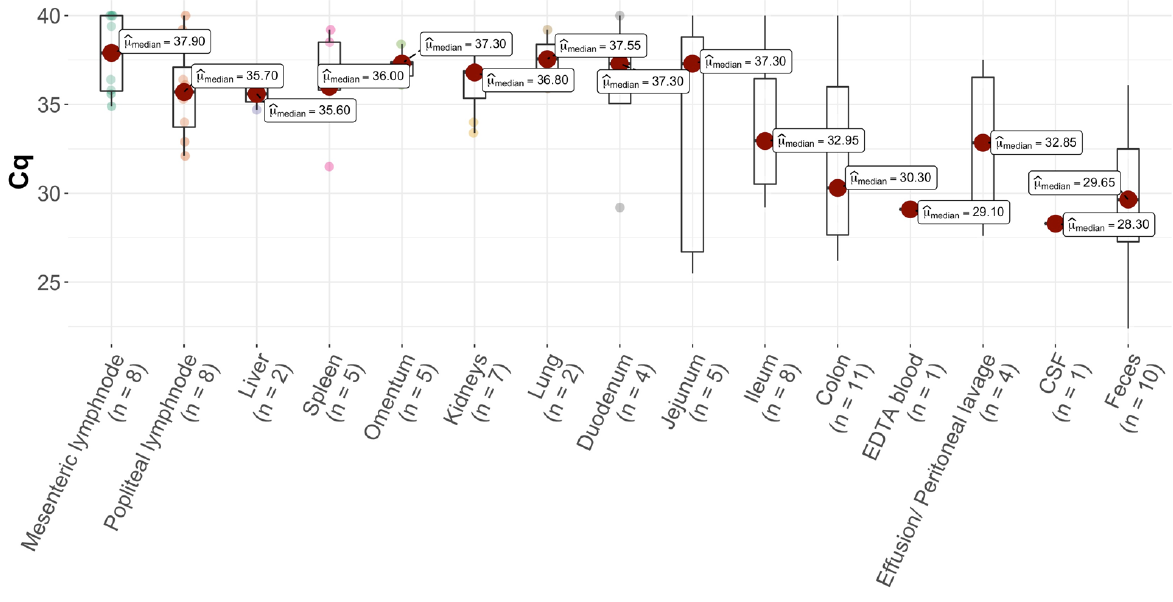
Figure 2. Box-whisker-plot comparing Cq values in tissue, fluid, and fecal samples from the 21 cats positive for feline coronavirus (FCoV) RNA in at least one sample. EDTA = ethylenediamine tetra acetic acid; CSF = cerebrospinal fluid.